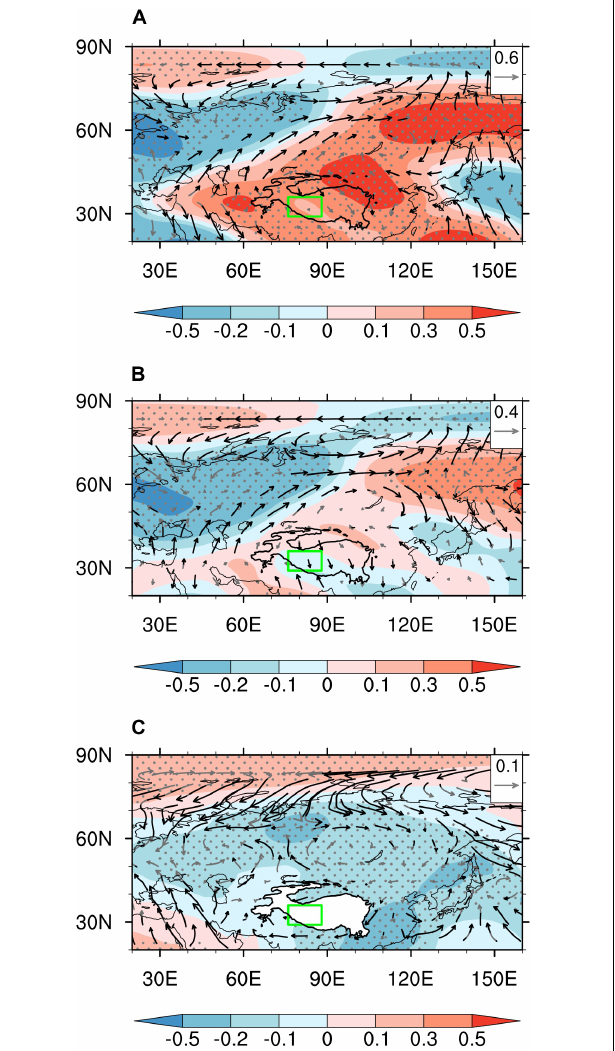
FIGURE 5 | Regression fields of the divergent wind (vectors; units: m/s) and velocity potential (shaded; units: 10 6 m 2 /s) at (A) 250, (B) 500, and (C) 1000 hPa, against the BSICI. Black arrows indicate vector values above the p = 0.1 confidence level. The shaded values of the stippled areas exceed the p = 0.1 confidence level. The green box represents the MWTP region. The black line over the region (25 ◦ –45 ◦ N, 60 ◦ –110 ◦ E) outlines the 2-km topography of the Tibetan